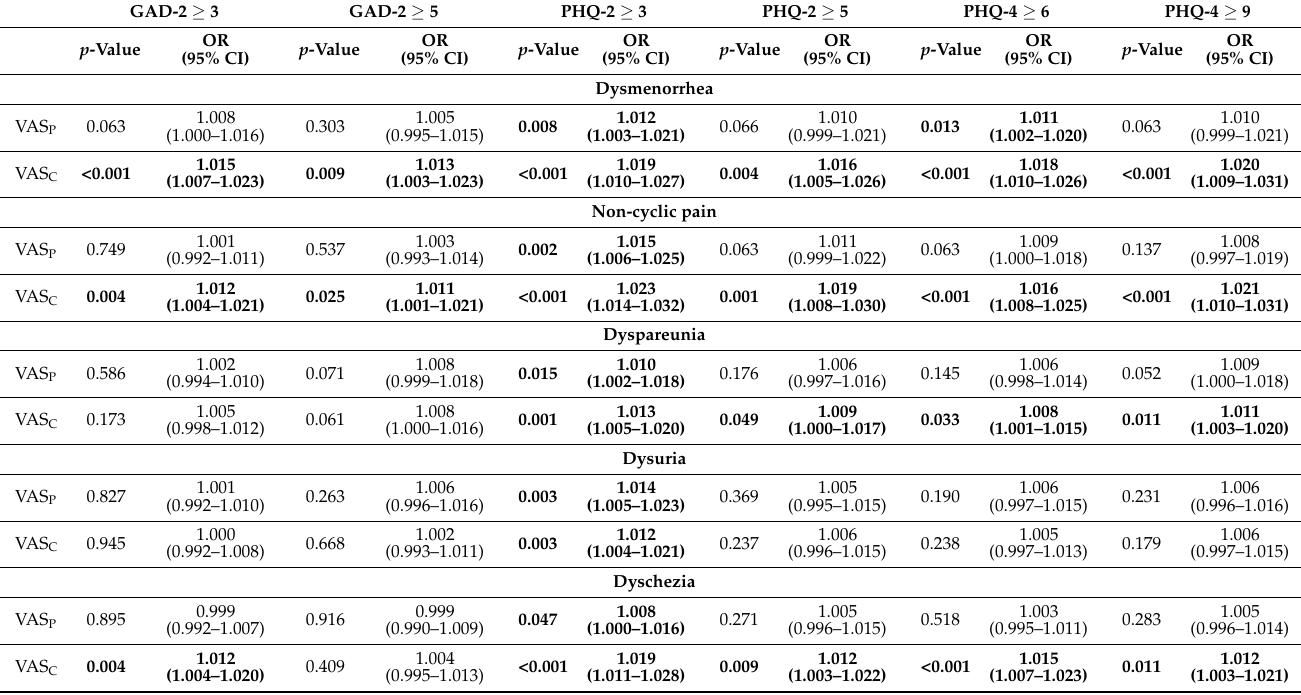
Table 5. Influence of previous and current pain intensity on self-reported mental health outcomes (univariate logistic regression